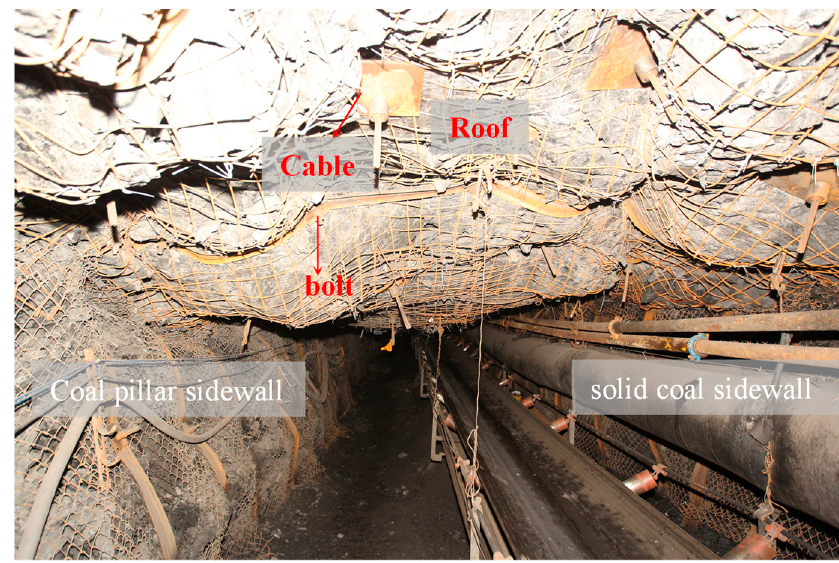
Figure 14. Photos of zone B in MTR 1513.